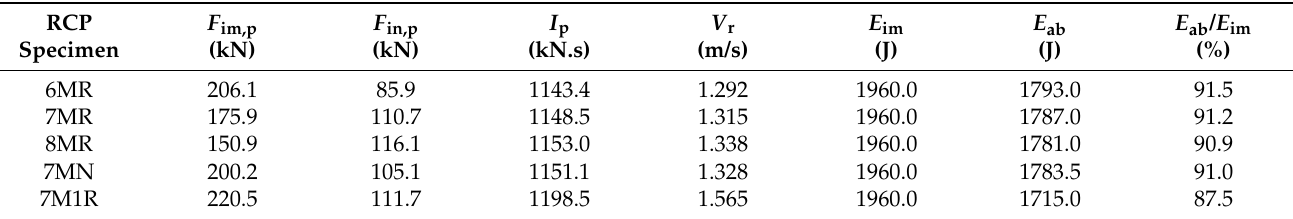
Table 6. Impact force characteristics of RCP